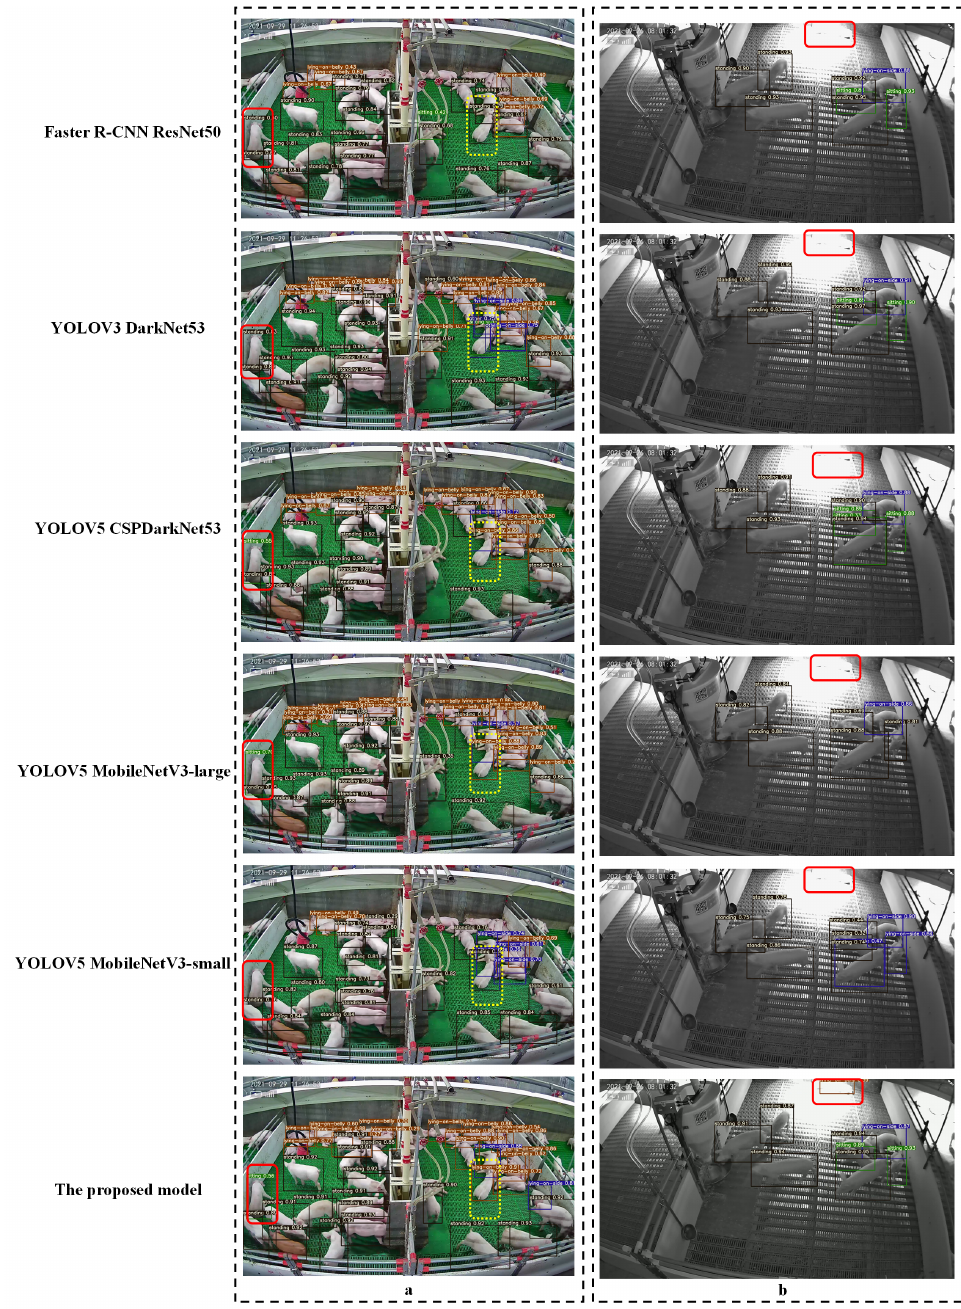
Figure 8. Examples of pig postures detection based on seven models. ( a ) example with lighting; ( b ) example without